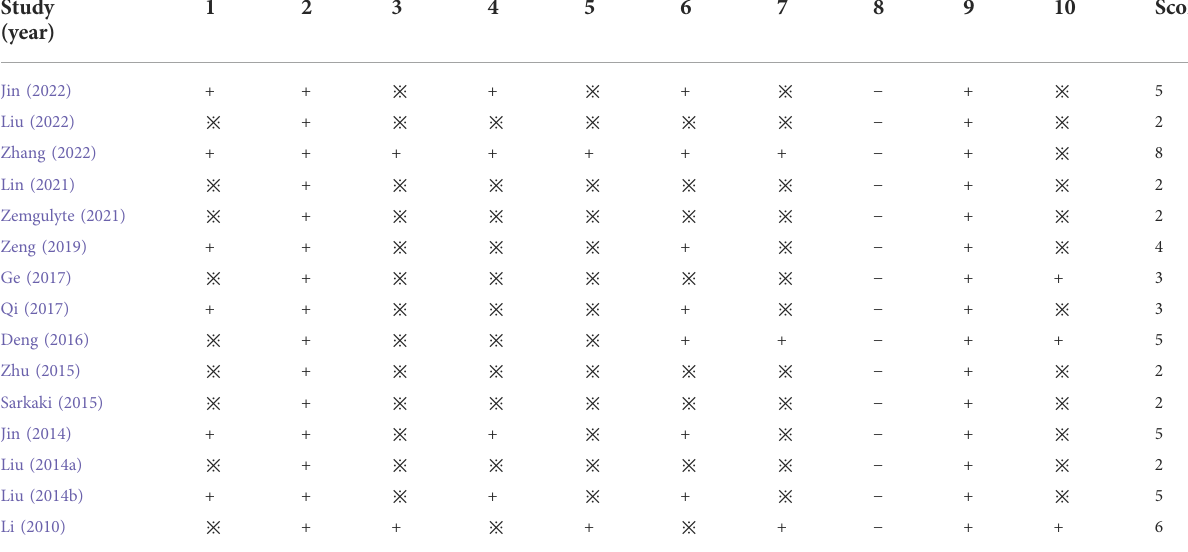
TABLE 2 Methodological quality of